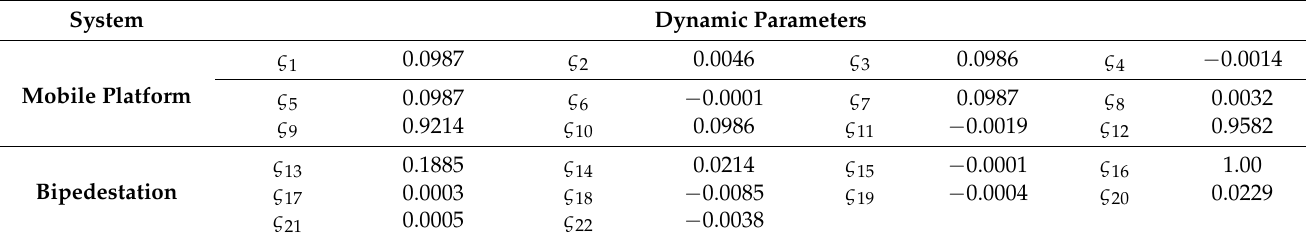
Table 2. Dynamic parameters ς of the standing human–wheelchair system for a person of 75 kg. System Dynamic